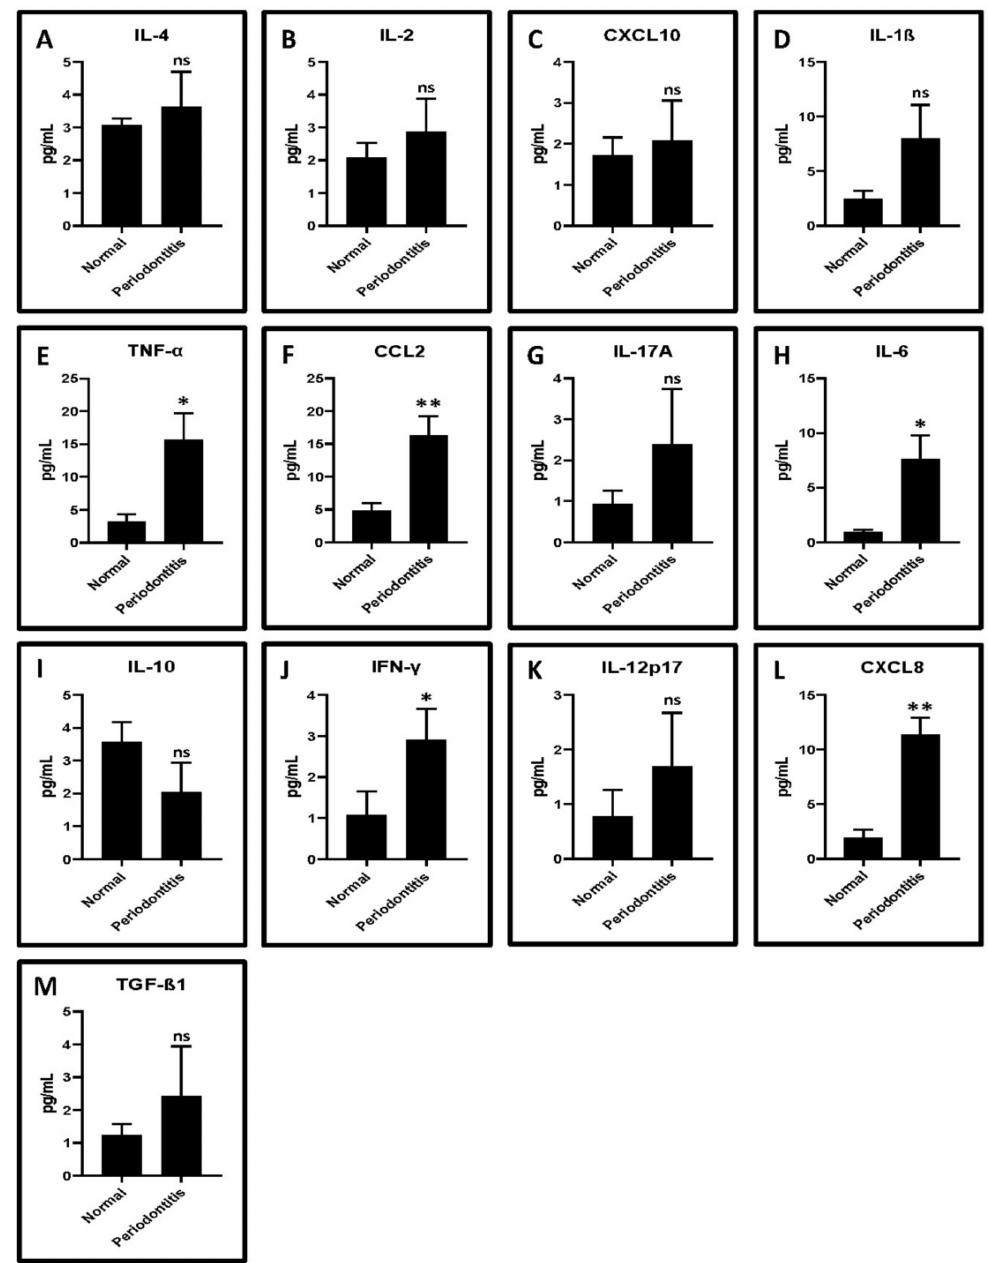
Figure 2. Cytokine levels in periodontally healthy versus diseased GCF samples. ( A – M ) Flow- cytometry-based analysis of human cytokines. The quantitation and comparative analysis of cy- tokines in the GCF samples were assessed by a cytometric bead array on the flow cytometer. ns not significant, * p < 0.05, ** p < 0.01. IL-4: interleukin 4, IL-2: interleukin 2, CXCL10: C-X-C motif chemokine ligand 10, IL-1 β : interleukin 1 beta, TNF- α : tumor necrosis factor alpha, CCL2: C-C motif chemokine ligand 2, IL-17A: interleukin 17A, IL-6: interleukin 6, IL-10: interleukin 10, IFN- γ : interferon gamma, IL-12p70: interleukin 12, CXCL8: interleukin 8, and TGF- β 1: transforming growth factor beta